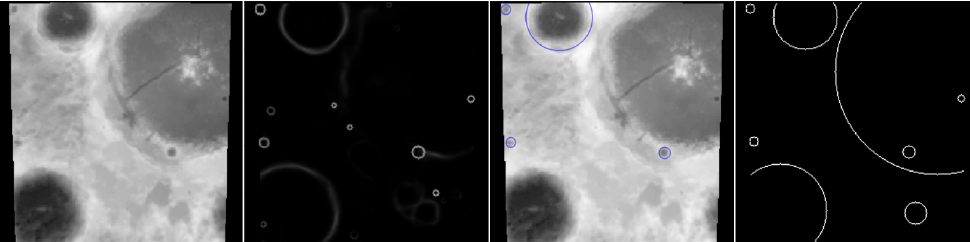
Figure 3. Different stages of the Deep Moon detection system compared to the ground truth. Going from left: (i) input DEM image, (ii) output of the CNN model, (iii) craters detected by the template- matching-driven algorithm, (iv) ground